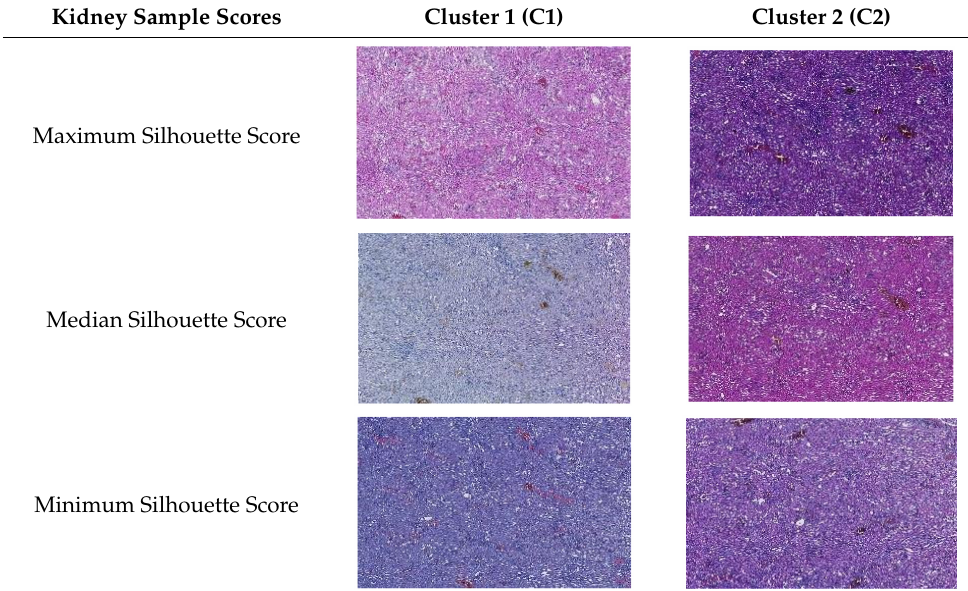
Figure 13. Silhouette scores and laboratories for the second found cluster (C2) in the kidney sample group. Table 3. Silhouette score rank-based visualization for both clusters in the kidney sample